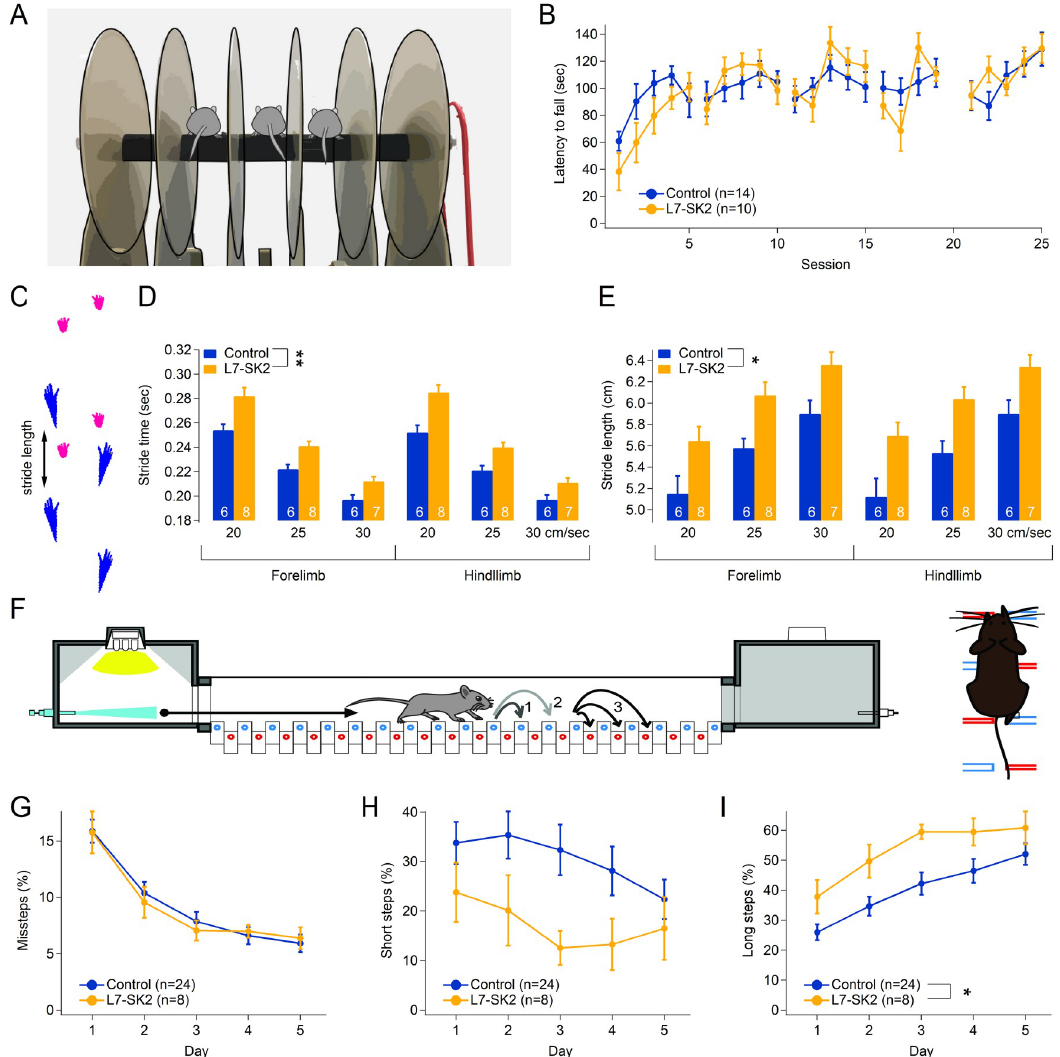
Fig 5. Gait patterns, but not overall walking performance, are altered in L7-SK2 mice. (A) Cartoon showing the layout of the rotarod apparatus. (B) Motor coordination on the rotarod was comparable in L7-SK2 and littermate WT control mice: the latency to fall was comparable, despite a nonsignificant trend for slower learning in L7-SK2 mice during the first 5 sessions corresponding to day 1. (C) Cartoon showing example paw prints (blue: hindlimbs, magenta: forelimbs) and stride length (arrow) as reconstructed from videos of a control mouse walking on a treadmill by the DigiGait software. (D–E) DigiGait analysis of mouse locomotion on a treadmill at fixed speed (20, 25, and 30 cm/s). The bar graphs show a significant increase in stride time (D) and a corresponding increase in stride length (E). (F) Cartoon depicting the design of the Erasmus Ladder, consisting of two shelter boxes on either side of a horizontal ladder that the mouse has to cross. Light and air puffs will nudge the mice to cross, typically using the upper (blue) bars and avoiding the lower (red) bars. Curved arrows indicate short (1), long (2), and lower steps (“missteps,” 3). (G) Over 5 days of testing, L7-SK2 mice make a similar number of missteps (lower rungs) as their WT controls. (H–I) L7-SK2 mice show a trend toward using fewer short steps (H) and more long steps (I), in line with the increased stride length observed in the DigiGait experiments. � p < 0.05; �� p < 0.01. See also S2 and S3 Figs and S1 and S2 Tables. WT, wild type.